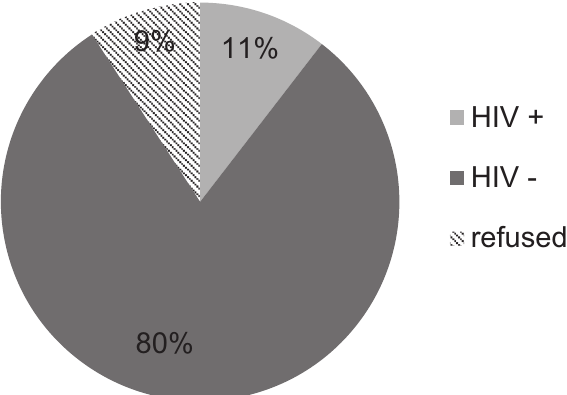
Figure 1. Total joint arthroplasty population voluntary counselling and testing results.